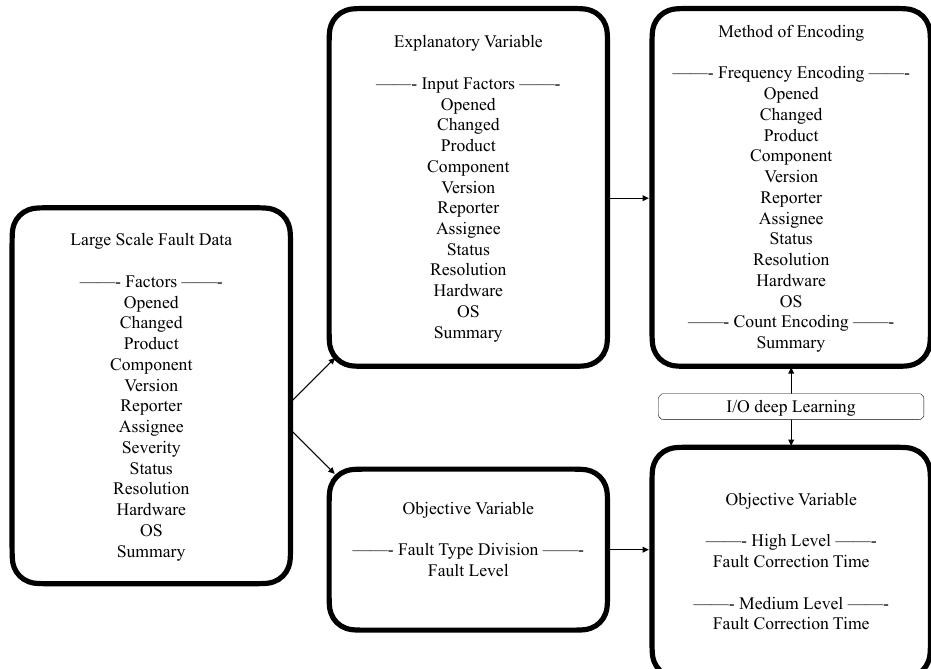
Figure 5. The structure of data